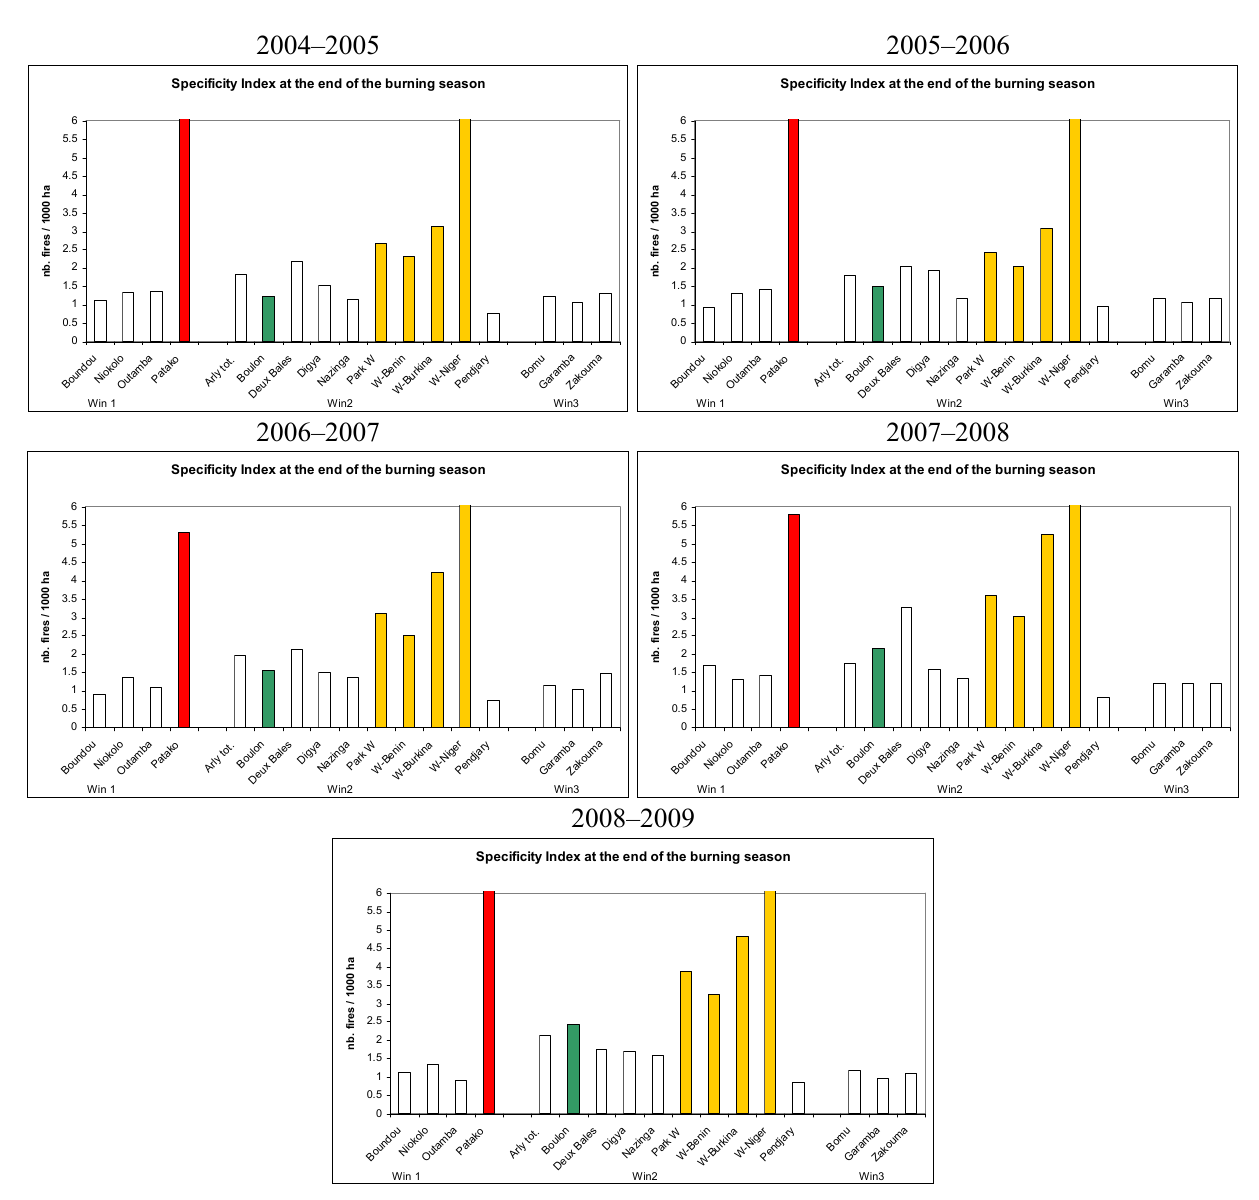
Figure 5. Specificity Index in the Patako (red), Boulon (green), Park W (orange) and 11 other protected areas of West and Central Africa from 2004 to